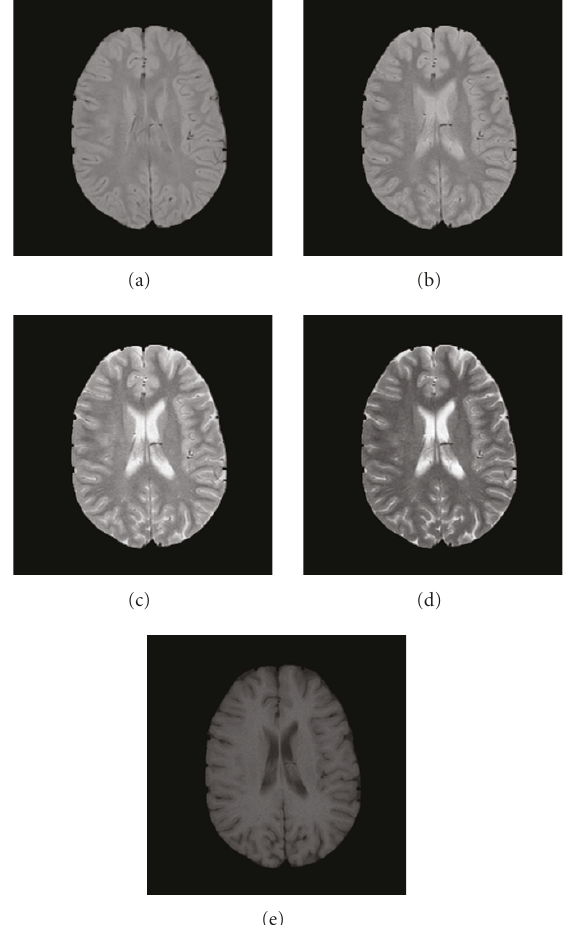
Figure 10: Actual brain MRIs: (a) TR1/TE1 = 2500ms/20ms; (b) TR2/TE2 = 1500 ms/55ms; (c) TR3/TE3 = 2500 ms/75ms; (d) TR4/TE4 = 2500 ms/100ms; and (e) TR5/TE5 = 500 ms/20ms. Table 2: Assessment results of AIS-CSA (5dB)